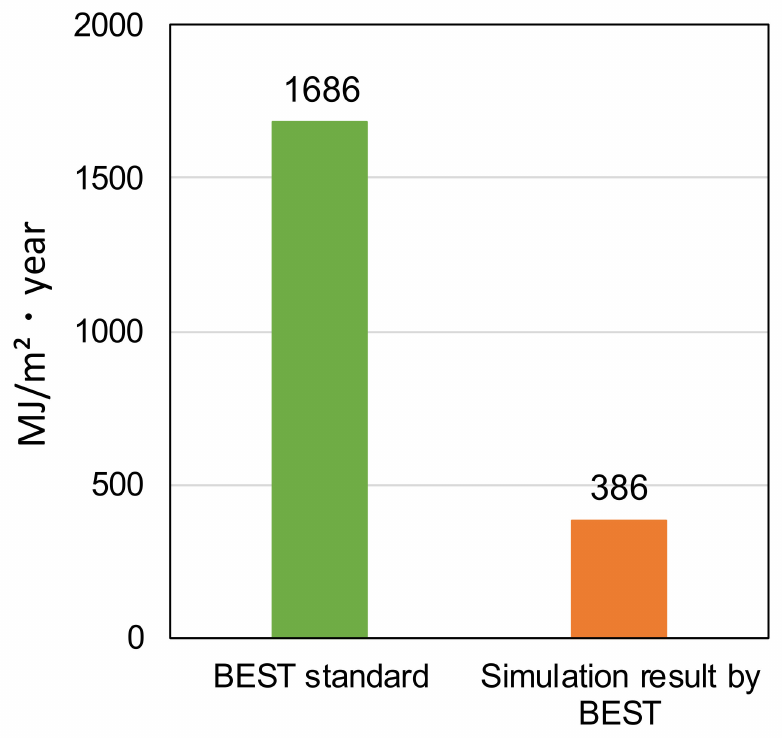
Figure 6. The simulation results of the annual primary energy consumption by the BEST program. There were no monthly differences in the primary energy consumption for ventilation, lighting, hot water supply, elevators, and outlets. However, the gas consumption of the main body of an air-conditioning heat source was widely used during the